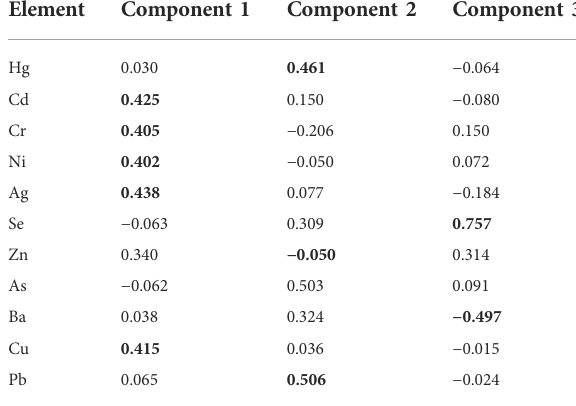
TABLE 5 Varimax rotated